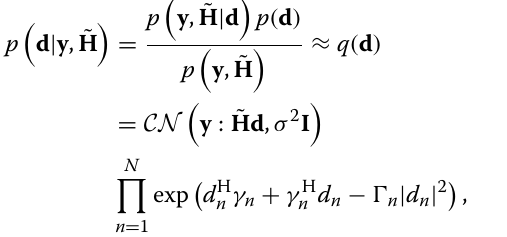
employed to resolve the codeword collisions. This scheme improves the SCMA-GFDM SER performance at the cost of a high complexity. The second approach proposed in this paper uses the BEP equalizer with a SMUD that reduces the complexity of the SCMA decoder, at the cost of an affordable SER performance degradation. These new schemes are presented in the following sections.